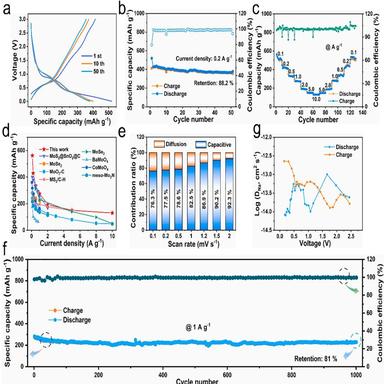
Electrochemical performance of L-FMO for SIBs. Galvanostatic charge and discharge voltage profiles (a) and cycling capability (b) at 0.2 A g− 1 . (c) Rate performance at different densities. (d) Comparison with other reported anode materials in SIBs. (e) Pseudocapacitive contribution ratio at various scan rates. (f) longterm cycling stability performance at high current density of 1 A g− 1 . (g) The calculated chemical diffusion coefficient for Na-ion.